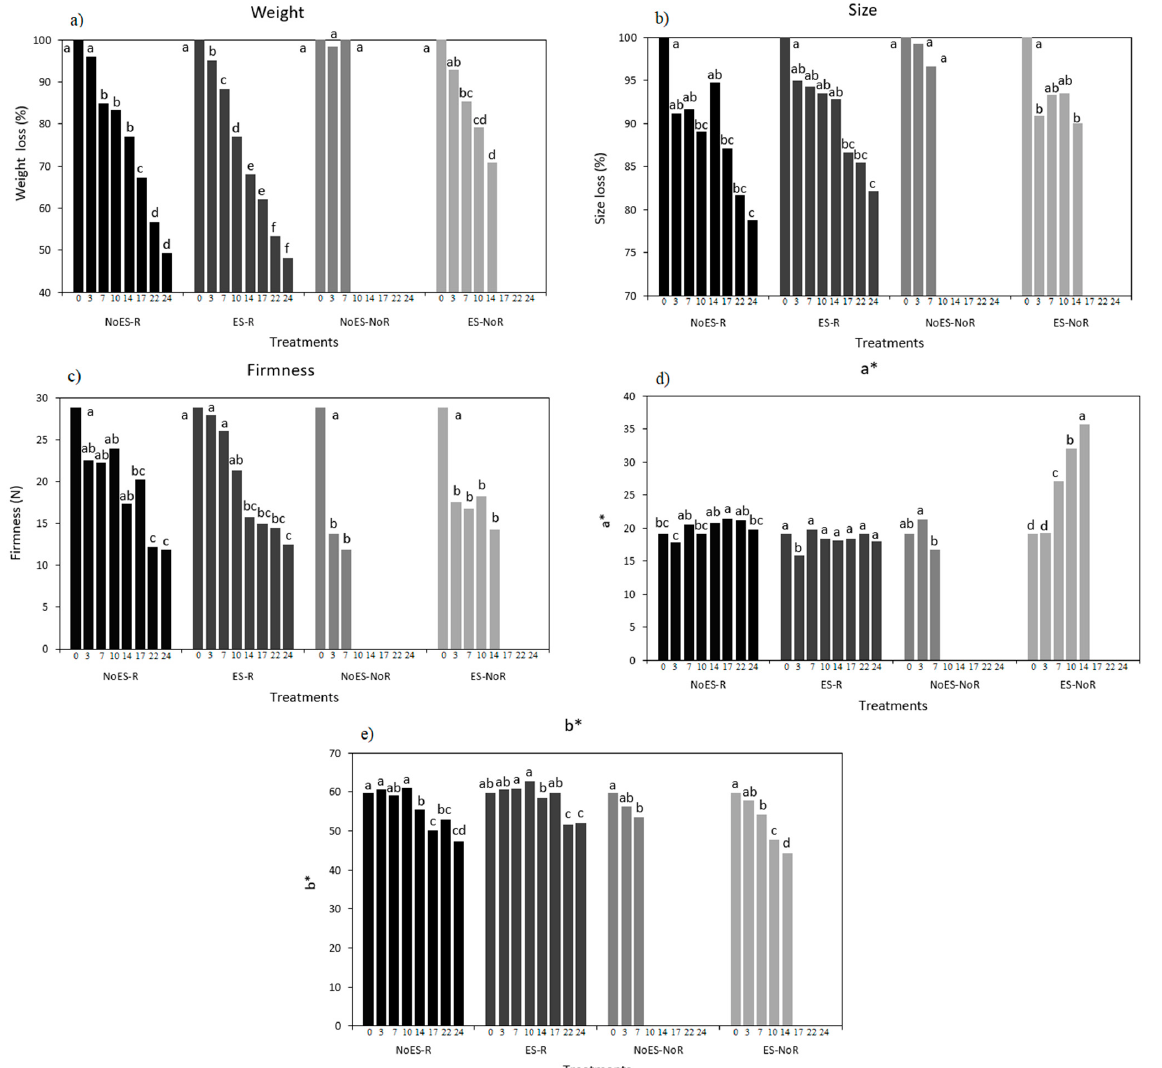
Figure 2. Loss of weight ( a ) and size ( b ) expressed as percentage and compared to initial day; firmness expressed in newtons ( c ); colour expressed as a* ( d ) and colour expressed as b* ( e ) coordinates in CIELAB system in peaches subjected to the different treatments (NoES-R, ES-R, NoES-NoR and ES-NoR). Different letters for every day in on treatment represent statistically significant differences according to Tukey’s test with the aim of assessing the evolution of each parameter for every treatment.